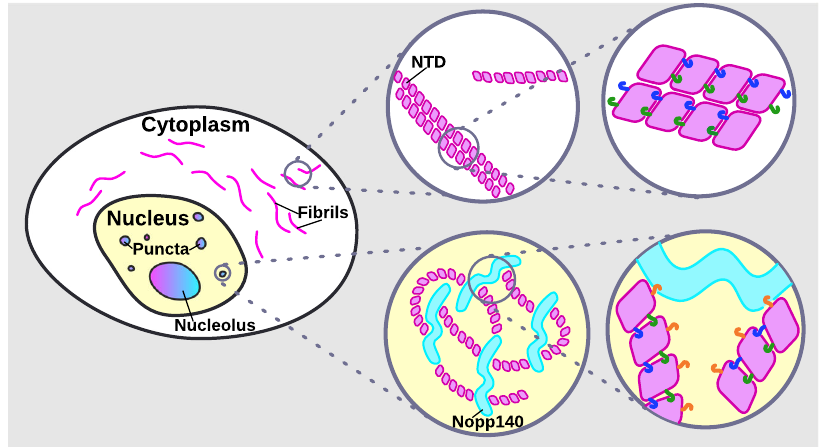
Fig. 7 | Working model for Cajal body assembly and maintenance via multi- valent coilin NTD – NTD and NTD – Nopp140 interactions. Schematic depicts coilinNTD fi brilsinthecytoplasm,whereNopp140isabsent.Inthenucleus,puncta may form by the remodeling of coilin NTD fi brils by Nopp140. Alternatively,